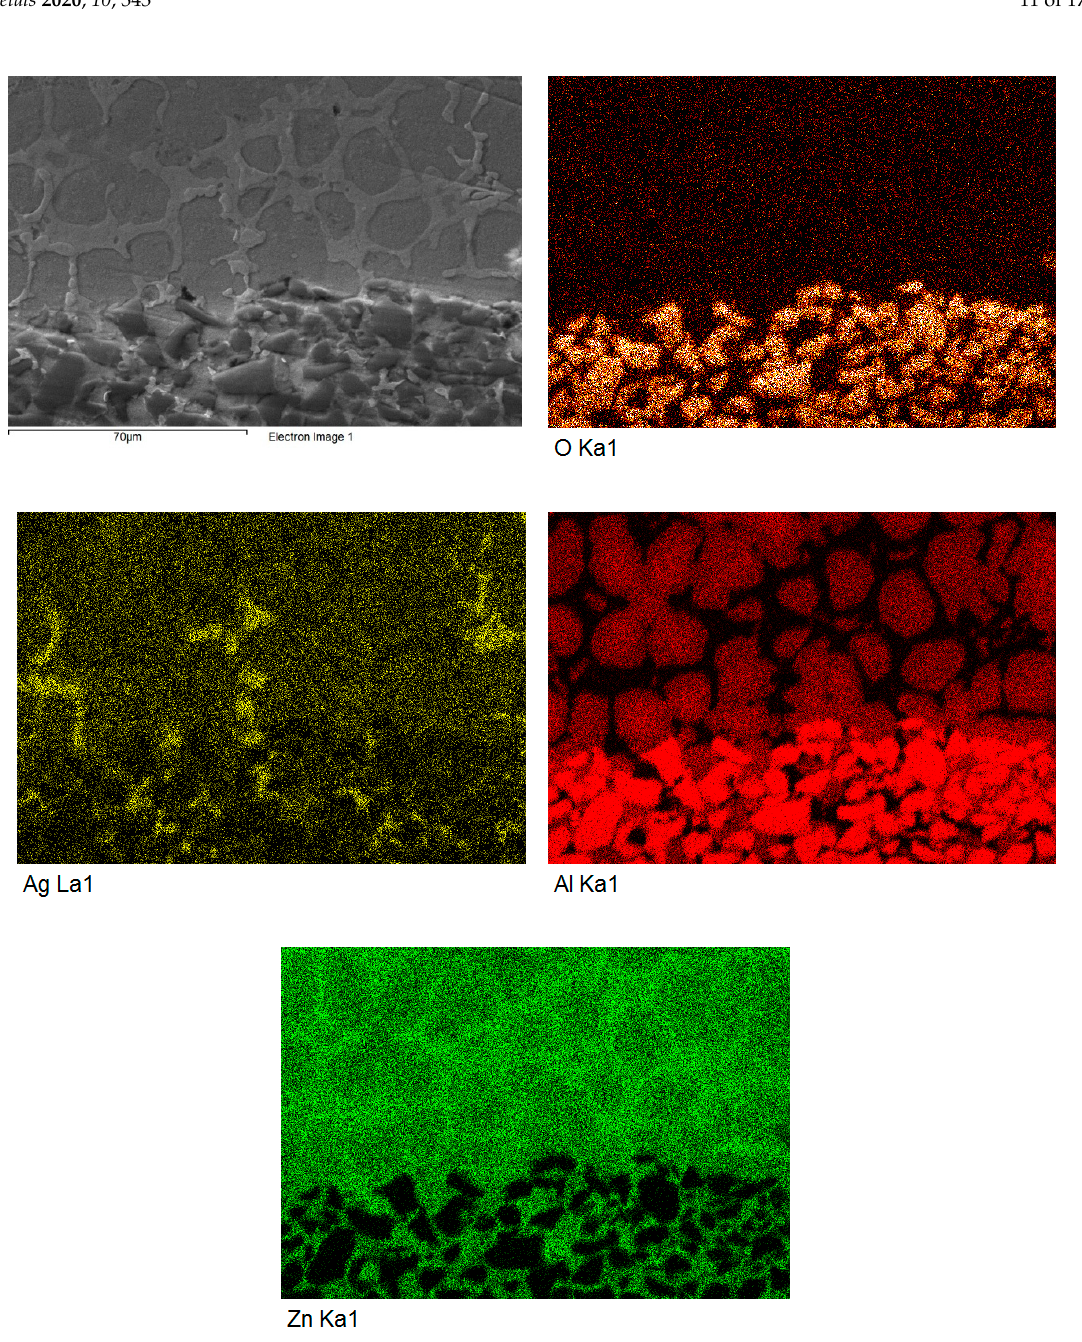
Figure 11. Planar distribution of elements in the boundary of MMC / Zn6Al6Ag soldered